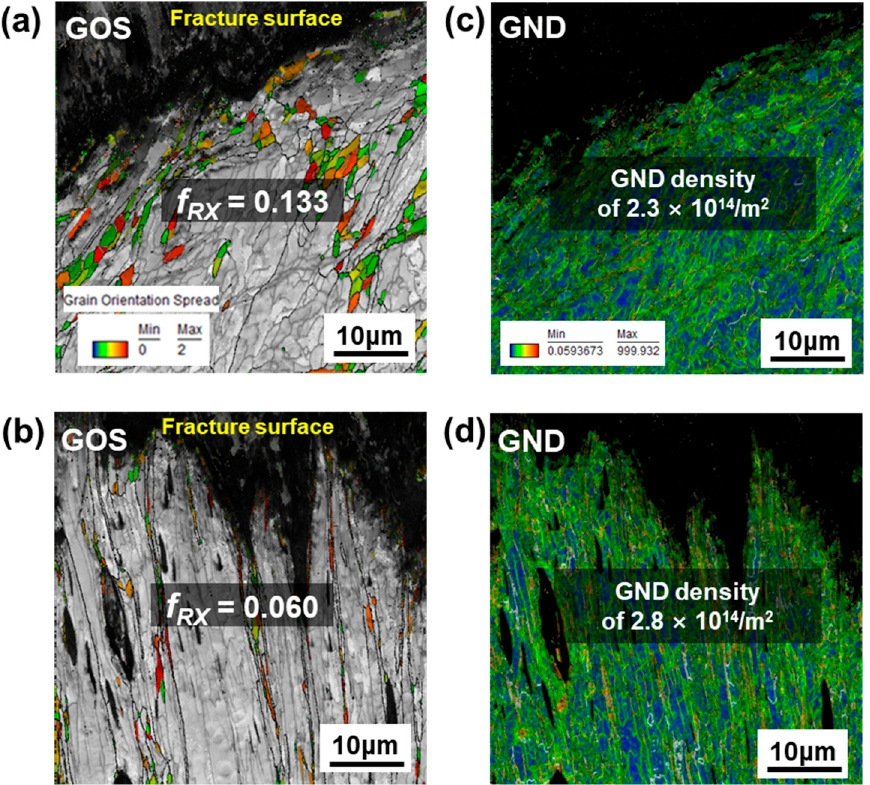
Figure 6. The GOS and GND maps of RX-W sample after tensile tests: ( a , c ) static (1.3 × 10 − 4 s − 1 ), ( b , d ) high-strain-rate (5.3 × 10 − 1 s − 1 ) conditions.